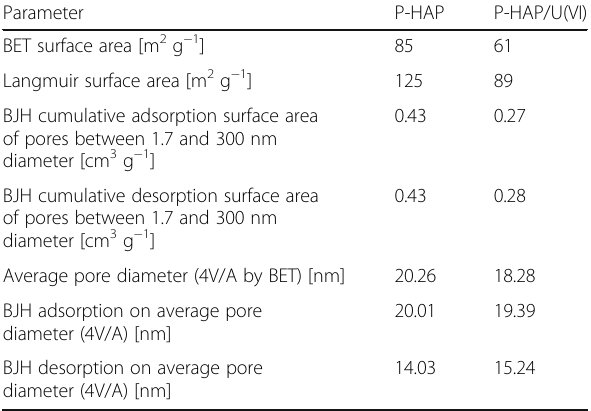
Table 2 Chosen structural parameters for P-HAP and P-HAP/U(VI) Parameter P-HAP